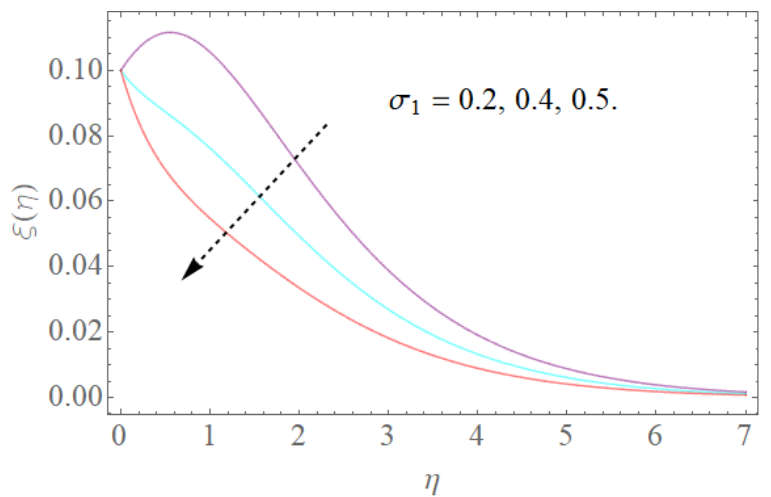
Figure 18. The effect of σ 1 on ξ ( η ) when P e = 0.4, L b =